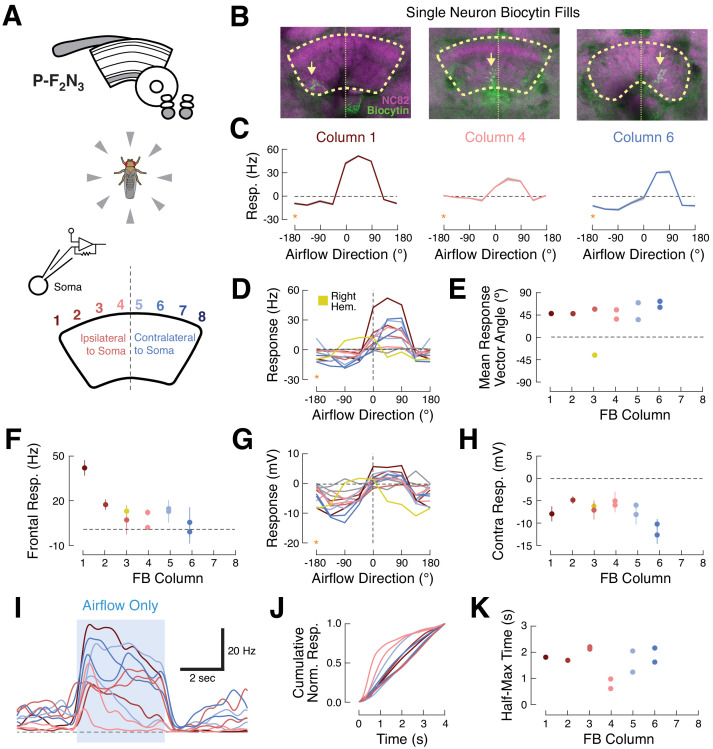
Ventral P-FNs exhibit similar ipsilateral airflow tuning across CX columns.(A) Top: CX neuropils innervated by P-F2N3. Bottom: experimental setup. We presented airflow from eight directions and identified the column innervated by each patched neuron by filling the cell with biocytin. (B) Biocytin fills (green) for three example cells innervating columns 1 (left), 4 (middle), and 6 (right). Yellow arrows indicate FB portions of fills. Neuropil in magenta. Thick dashed line indicates the borders of the FB and thin dotted line shows the midline. (C) P-F2N3 airflow tuning is similar across FB columns. Mean +/- SEM spiking response as a function of airflow direction for the three example cells shown in (B). Data at −180° is replotted from 180° for clarity (orange stars). Colors reflect innervated column, as in (A). (D) Mean spiking response as a function of airflow direction for all recorded P-F2N3 neurons. Colors as in (A). A single right-hemisphere neuron is shown in yellow. Gray curves indicate cells for which no anatomy data could be recovered. Data at −180° is replotted from 180° for clarity (orange star). (E) Mean response vector angle as a function of column for each recorded neuron. Colors as in (D). (F) Mean +/- SEM spiking response to frontal airflow as a function of column. Colors as in (A). (G) Mean membrane potential response as a function of airflow direction for each neuron. Data at −180° is replotted from 180° for clarity (orange star). Colors as in (D). (H) Mean +/- SEM membrane potential response to contralateral airflow as a function of column. Colors as in (D). (I) Timecourse (PSTH) of airflow responses to ipsilateral airflow for the same P-F2N3 neurons (average of 4 trials). Blue box indicates 4 s stimulus. Colors as in (A). (J) Cumulative normalized response for each neuron during the 4 s stimulus, normalized to its mean integrated response. Transient responses show fast rise times and tonic responses show slower rise times. Colors as in (A). (K) Time to half-max (a measure of response transience) as a function of column. Colors as in (A).